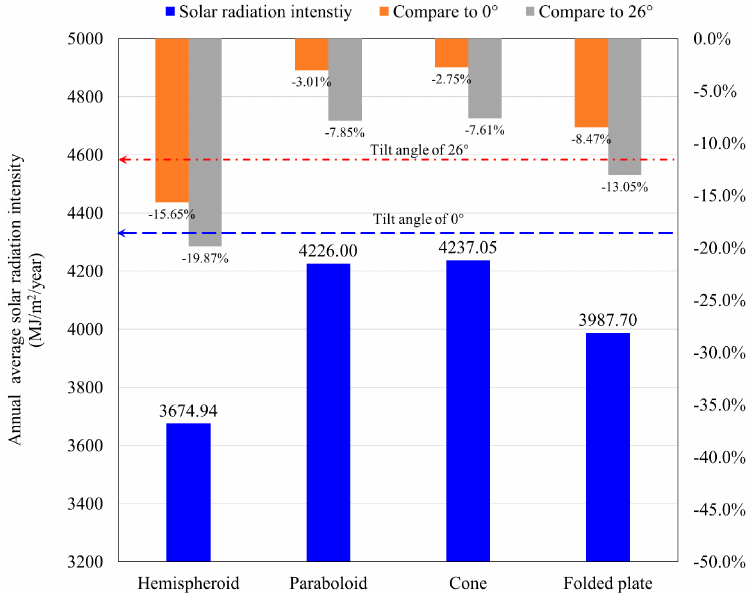
Figure 10. Monthly average solar radiation intensity of circular gymnasium buildings with the four roof shapes.